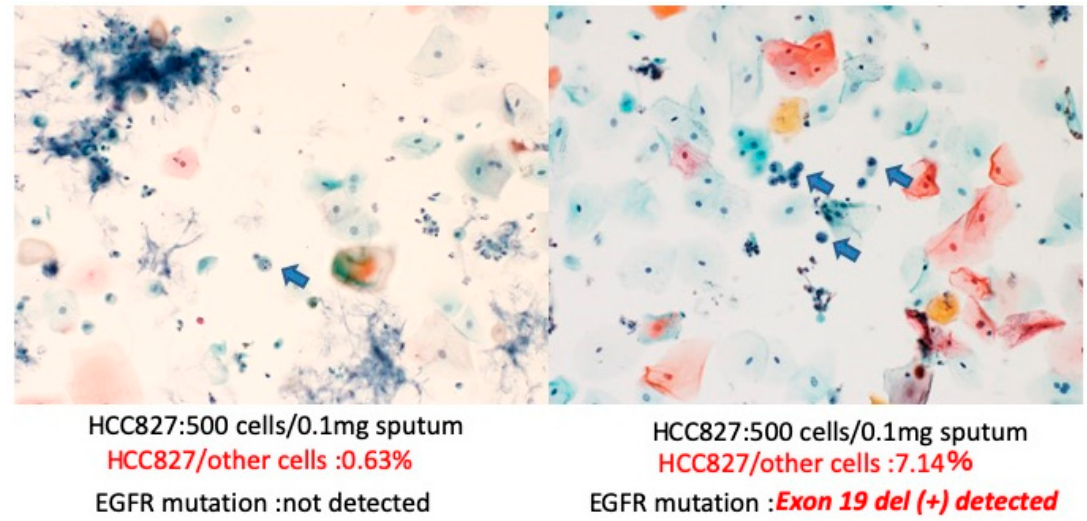
Figure 5. Papanicolaou stain for sputum LBC specimen containing HCC827 cells ( × 200). The left panel shows cytology specimen of case 3 including 500 cells of HCC827 / 0.1 mg sputum; The right panel shows cytology specimen of case 1 including 500 cells of HCC827 / 0.1 mg sputum. Arrows indicate HCC827 cells in the sputum.